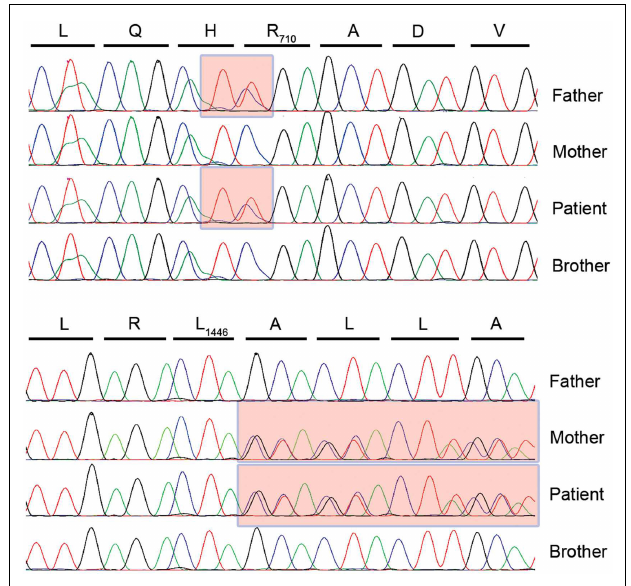
FIGURE 3 |TTC37 sequence electropherograms for the four members of the kindred in the region corresponding to the paternally inherited c. 2128C > T mutation (upper panel) and the maternally inherited c. 4337_4338insCTA insertion (lower panel)